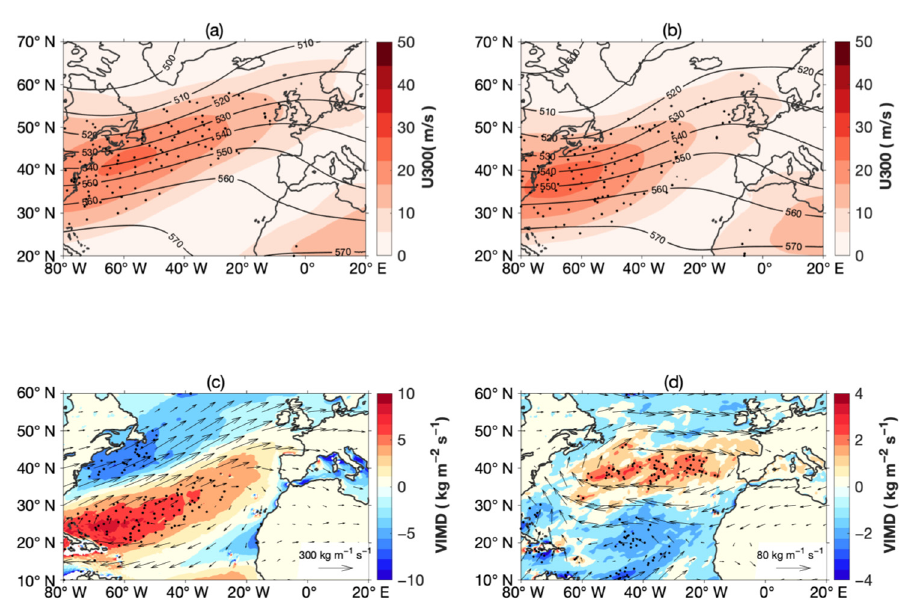
Figure 6. ( a ) Colors are distribution of U on 300 hPa (colors, m/s) and Z on 500 hPa (10 m, contours) in NAT+ phase. ( b ) Same as ( a ) but for NAT − phase. ( c ) Colors are distribution of VIMD (kg m − 2 s − 1 ) in NAT+ phase. Vectors are vertical integral water vapor flux (kg m − 1 s − 1 ) in NAT+ phase. ( d ) Difference in VIMD (color) and vertical integral water vapor flux (vectors) between NAT+ and NAT − phases. Black dots mark the difference above 95% confidence level based on a Student’s t test.